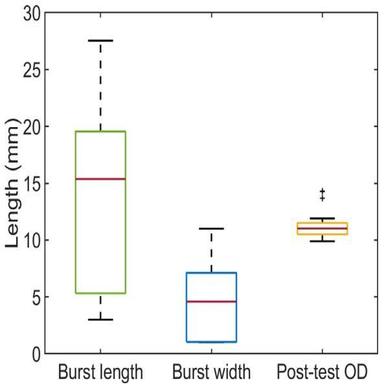
Distribution of the burst parameters showing the median (red line in the boxes). The post-test OD two outliers shown by +.